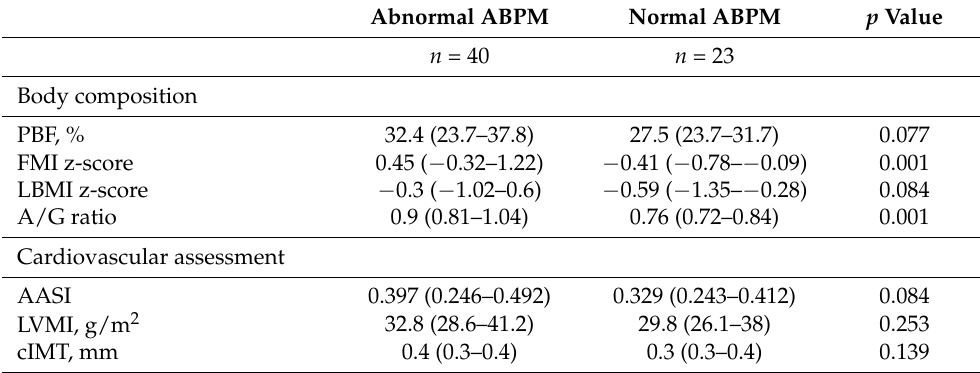
Table 3. Comparison of body composition and CV assessments in children with CKD stratified for abnormal and normal ABPM profile.